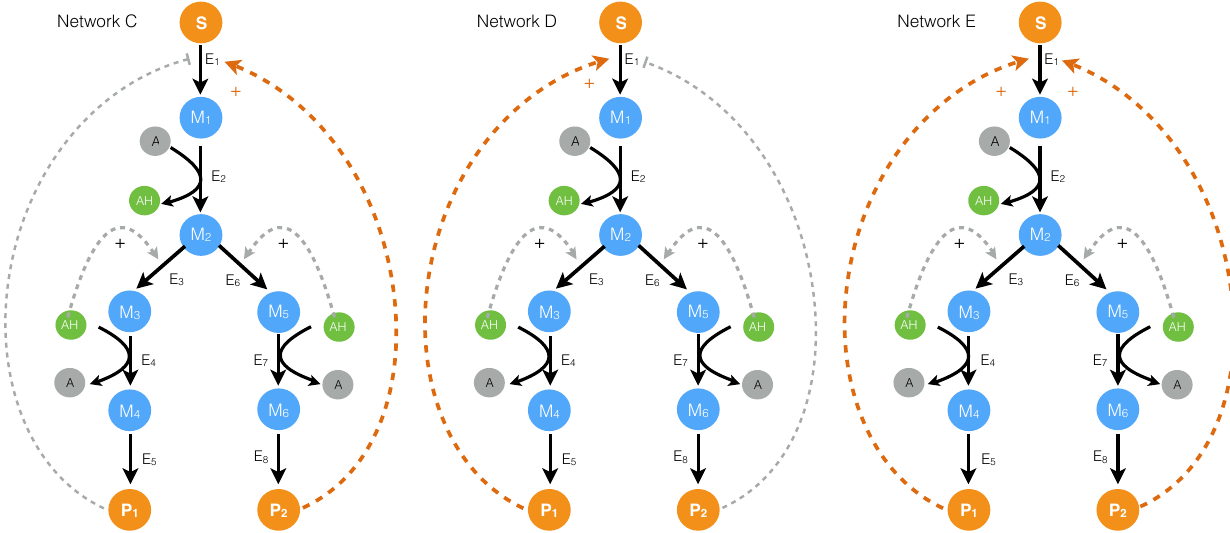
Figure 6. Schematic of the alternative allosteric control programs used in the structural particle swarm computation. Each network had the same enzymatic connectivity, initial conditions and kinetic parameters, but alternative feedback control structures for the first enzyme in the